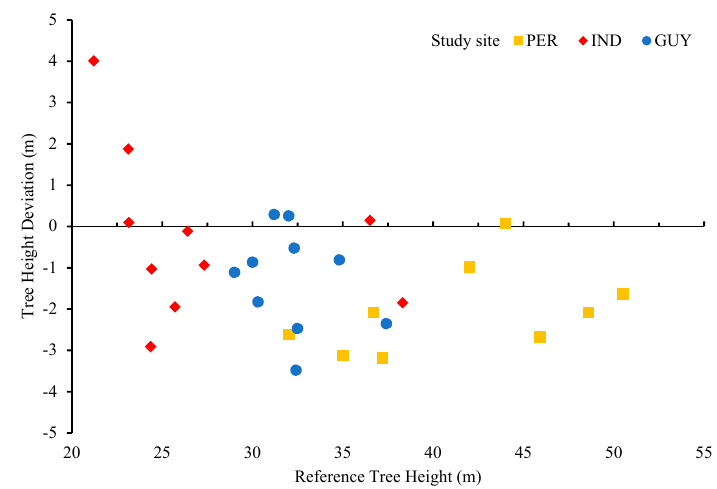
Figure 14. Tree height deviation for each sample.